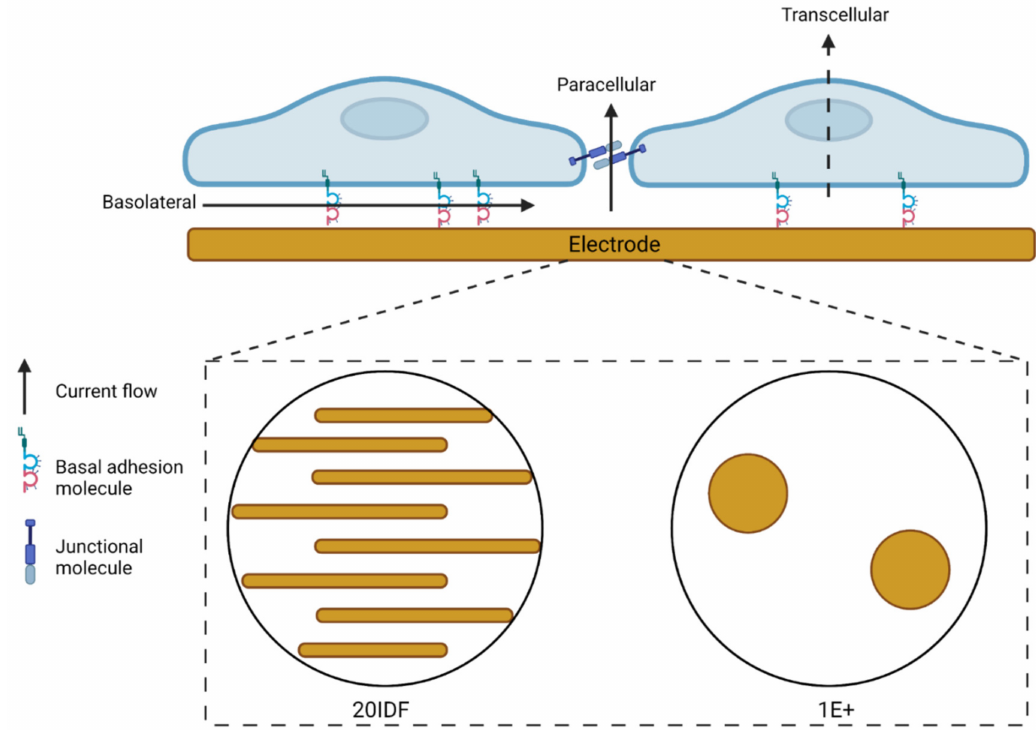
Figure 1. Electric cell-substrate impedance sensing (ECIS) schematic of current flow. Resistance measurements acquired by ECIS are a consequence of current flow through multiple pathways. Current flows through the basolateral, paracellular, and transcellular compartments. The cellular biology dictates the pathway that provides the most resistance to current flow. Current flow is impeded by the presence of strong basal adhesion proteins, paracellular junctional proteins and the cell body atop the electrode. ECIS electrode configurations include, but are not limited to, an interdigitated orientation of electrodes that measure a large surface area of a well, or two small circular electrodes that measure a comparatively smaller surface area of a well. Consult the Applied Biophysics website (https://www.biophysics.com/; accessed on 19 October 2021) for the most up-to-date array types and